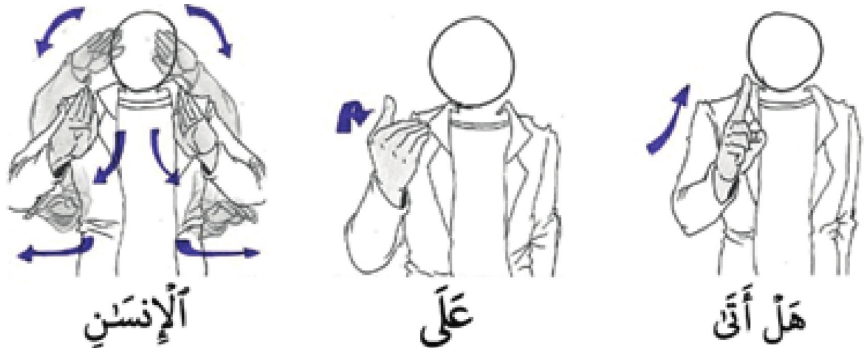
Figure 5: Kinesthetic submenu.